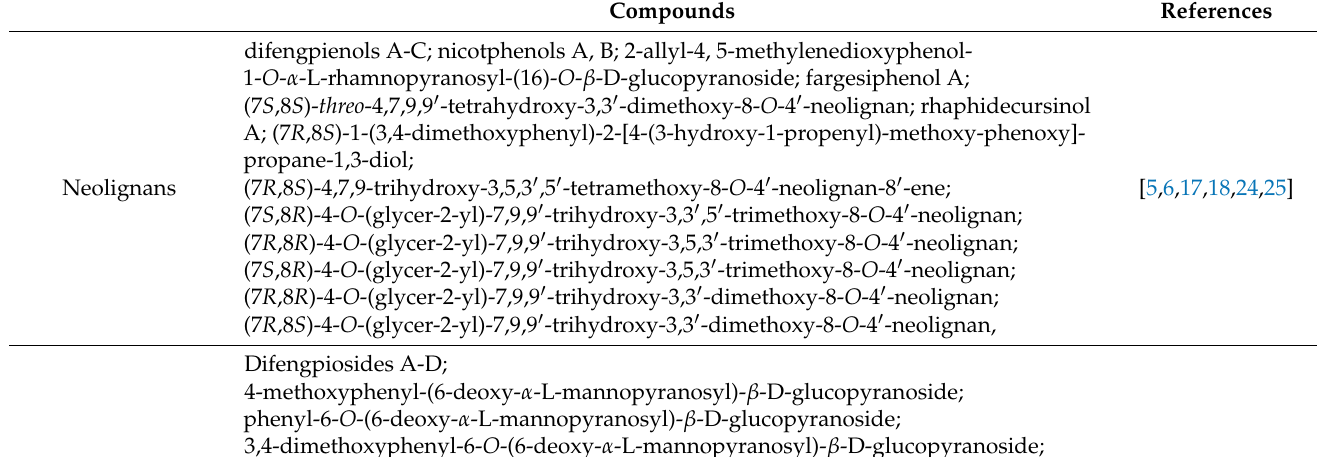
Table 2. Compounds isolated from the I. difengpi (Illiciaceae) plants.